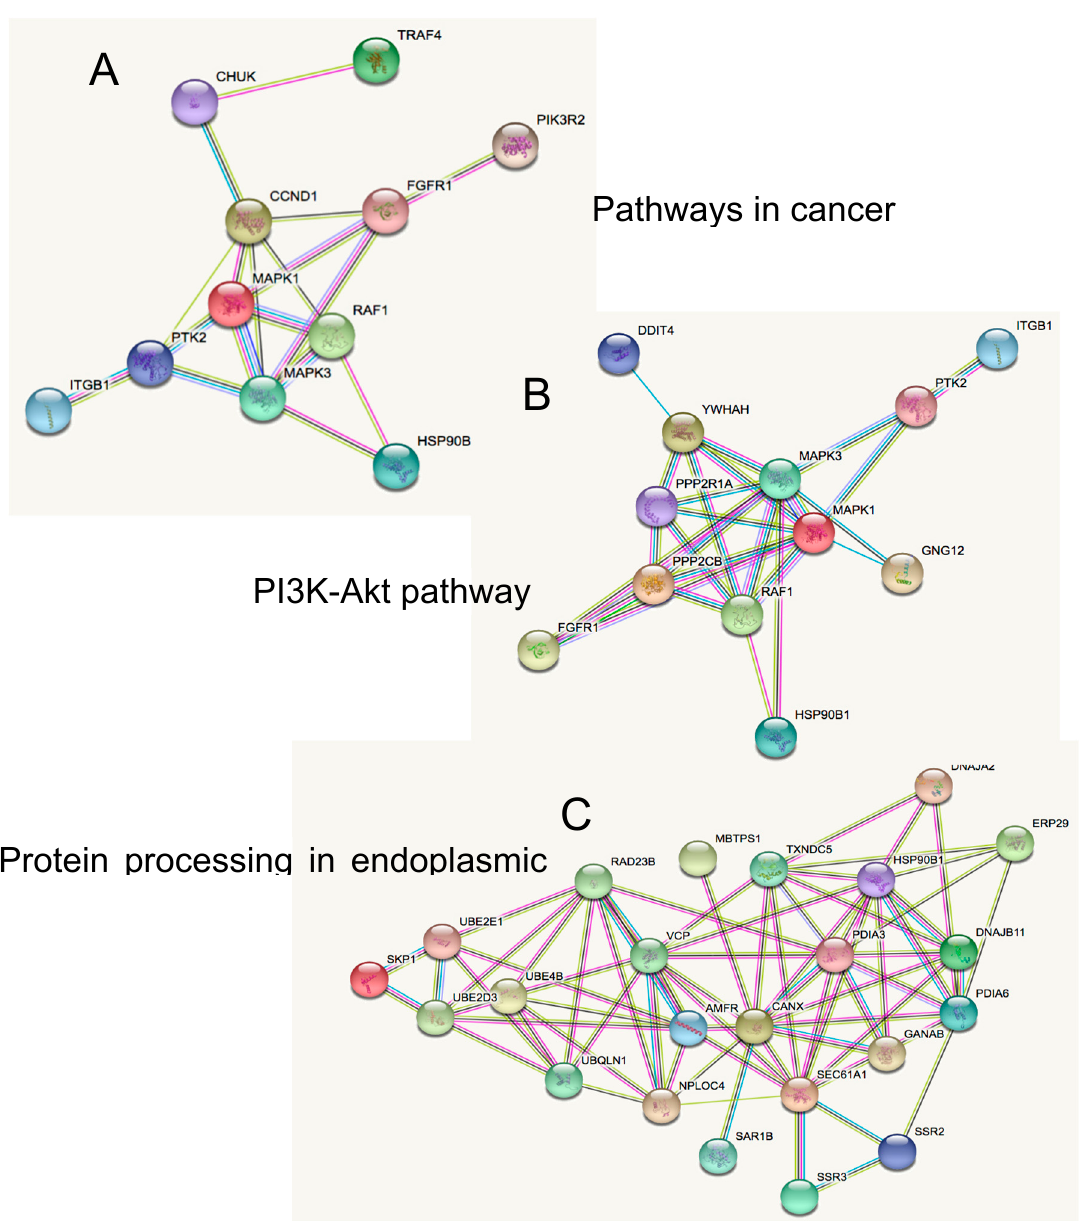
Figure 5. Putative targets of up-regulated miRNAs in SHH MB CSC enriched pathways, include ( A ) pathways in cancer, ( B ) PI3K-Akt pathway, and ( C ) protein processing in endoplasmic reticulum.